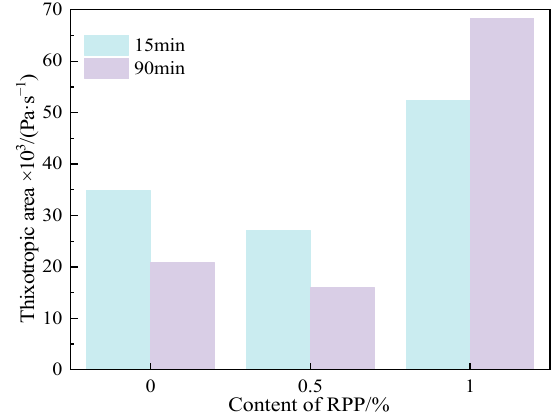
Figure 9. Thixotropic area of C-RPP pastes.